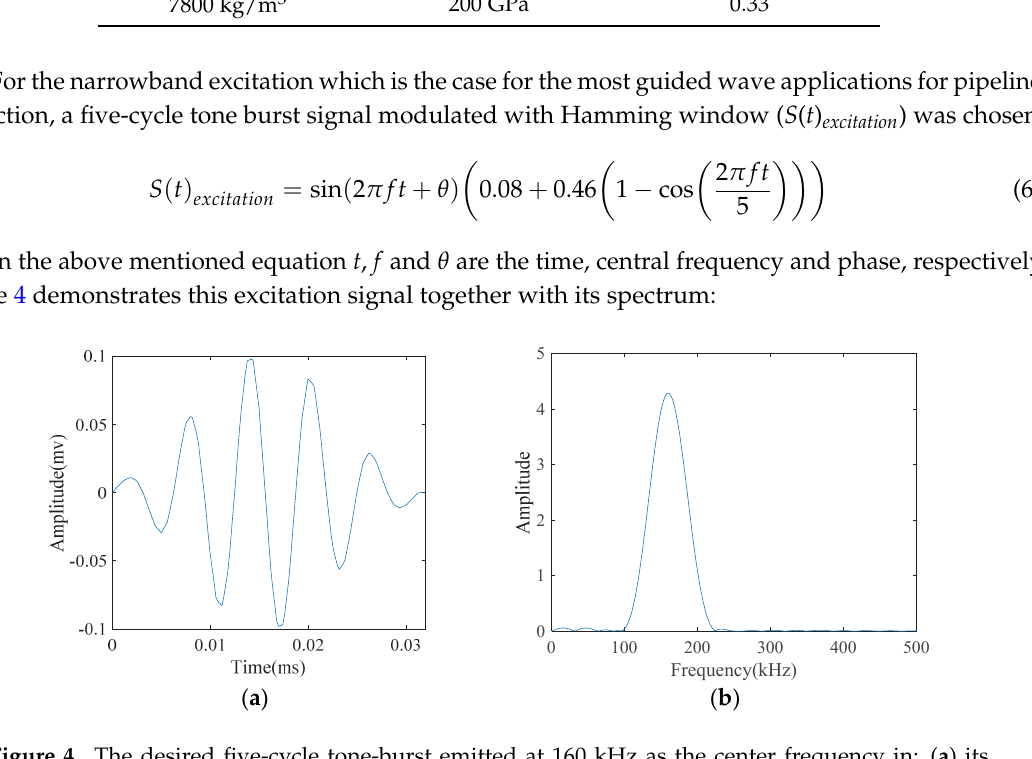
Table 1. The parameters used in the Finite Element Method (FEM) simulations. Density ( ρ )